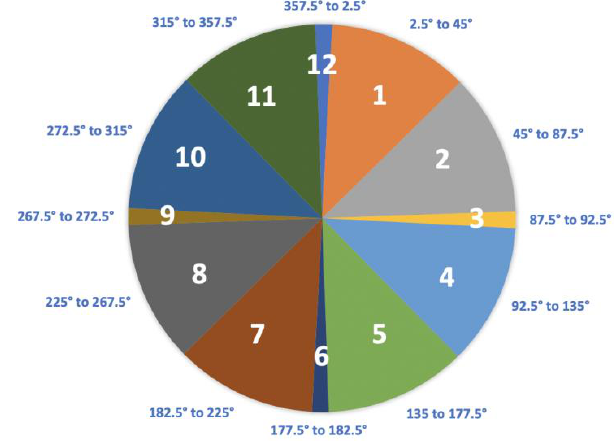
Figure 2. The Body Orientation During Sleep Framework (BODS).